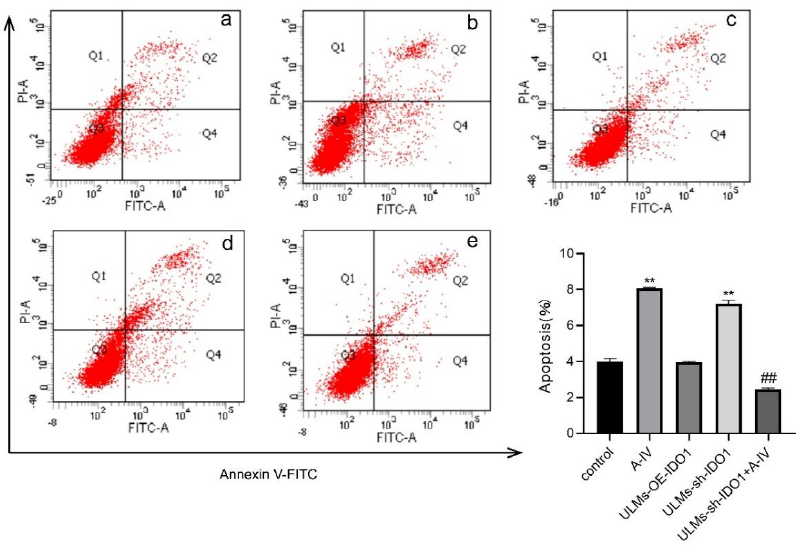
Figure 5. Detection of apoptosis rate in ULM cells by flow cytometry. ( a ) Control group; ( b ) A−IV group; ( c ) ULM−OE−IDO1 group; ( d ) ULM−sh−IDO1 group; ( e ) ULM−sh−IDO1 + A−IV group. Q1: Annexin V-/PI+, representing cellular debris or necrotic cells from other causes. Q2: Annexin V+/PI+, represents advanced apoptotic or necrotic cells. Q3: Annexin V-/PI-, represents normal living cells. Q4: Annexin V+/PI-, representing early apoptotic cells. The data are presented as the mean ± SD. ( ** p < 0.01 compared with the control group; ## p < 0.01 compared with the A-IV group).